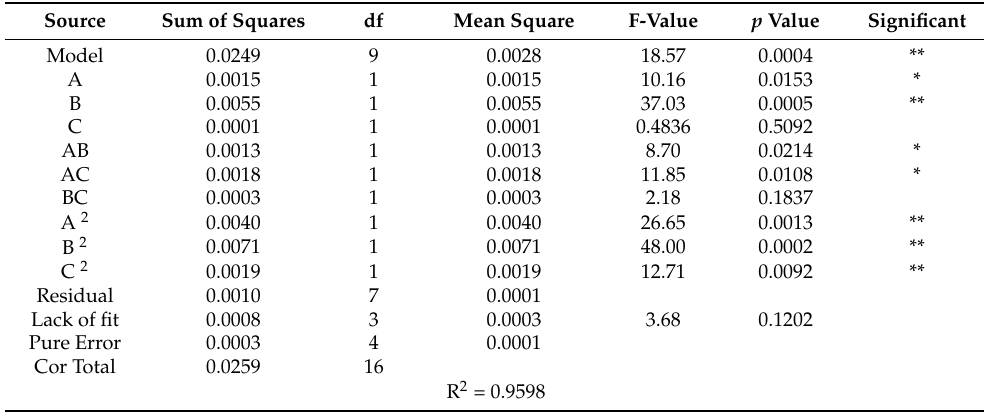
Table 1. The anova of quadratic polynomial